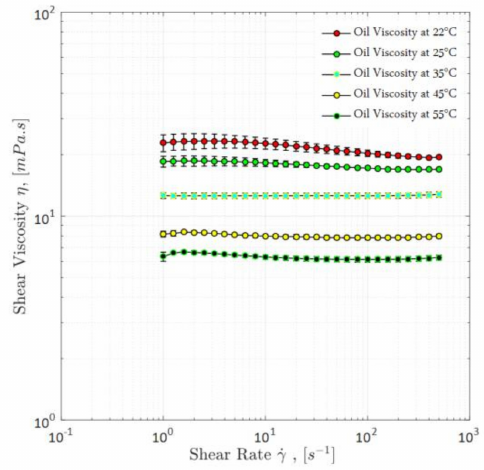
Figure6. Steady-shearviscosityofoilsampleTM-206atatemperaturerangeof22–55 ◦ C.Errorsobserved in the range of